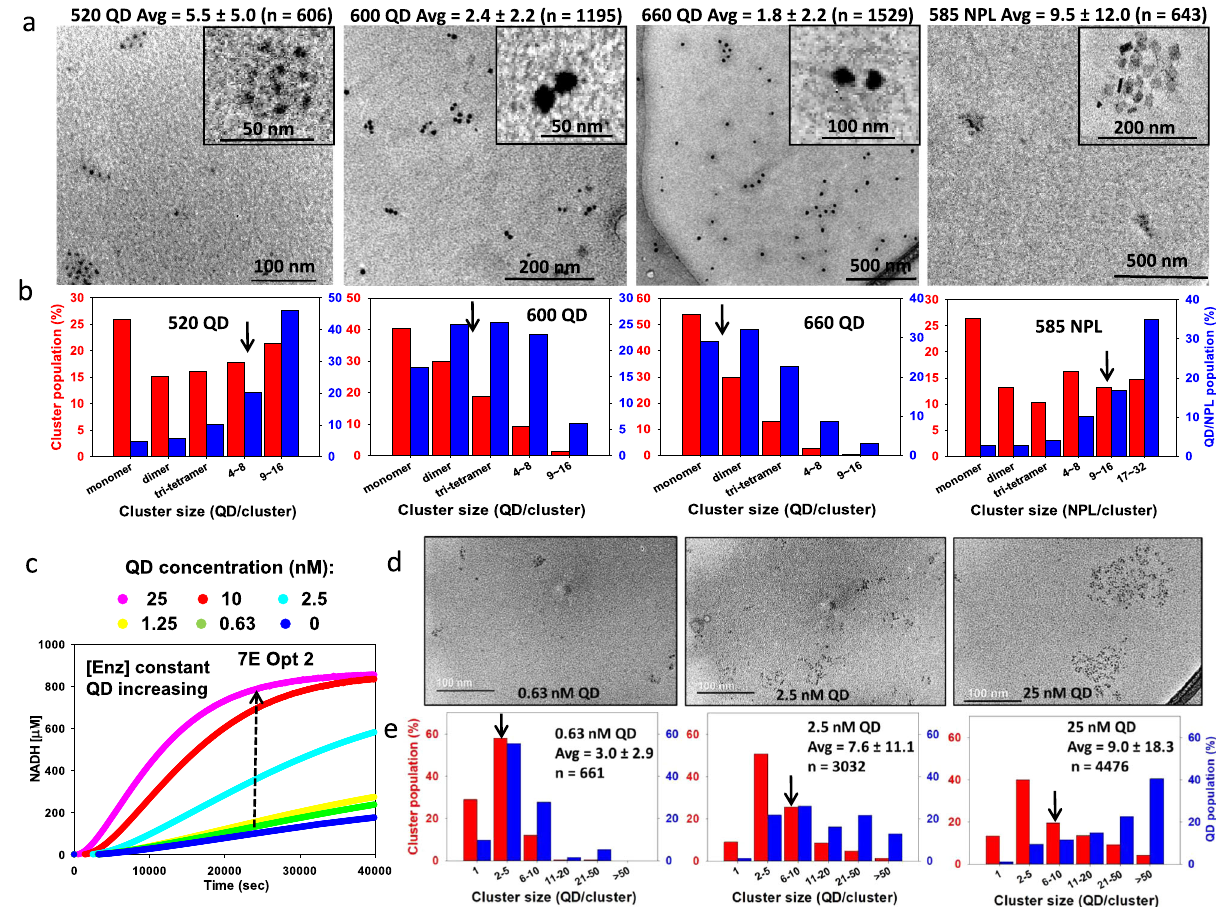
Fig.4|TEMcharacterizationofnanoparticle-enzymeclusters.a Lefttotheright, representative TEM micrographs of clusters formed with 520 QDs, 600 QDs, 660 QDs, and 585 NPL materials using the 7E cascadeat Opt2 ratios with QD=6.25nM and NPL=1.25nM. The average cluster size is given above the micrograph, along with the number of QDs counted in that determination. Inset, representative high- resolution micrograph of an individual cluster. In interpreting these images, it shouldberememberedthatchangesmayhaveoccurredeitherindepositiononthe TEM grids or in the high vacuum of the TEM. Enzymes can be seen in the TEM imagesasshadingaroundsomeofthe520and660QDs. b Correspondingbarplots foreachsamplein( a )showingthedistributionofclustersizespresent(red)andthe